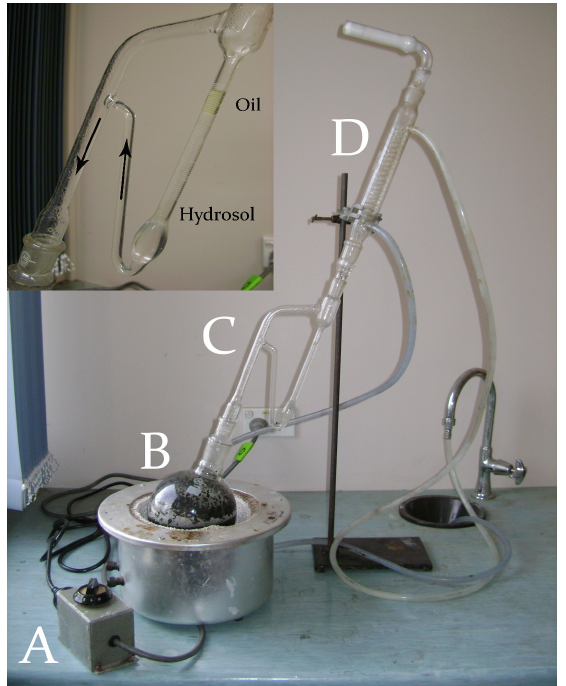
Figure 1. Hydrodistillation using the Clevenger-type apparatus. ( A ) Power regulator; ( B ) Heating mantle with round bottom flask containing water and aromatic leaves; ( C ) Clevenger-type apparatus which returns the hydrosol to the still and maintains the essential oil phase, but only for essential oils that are less dense than water and therefore float; ( D ) The